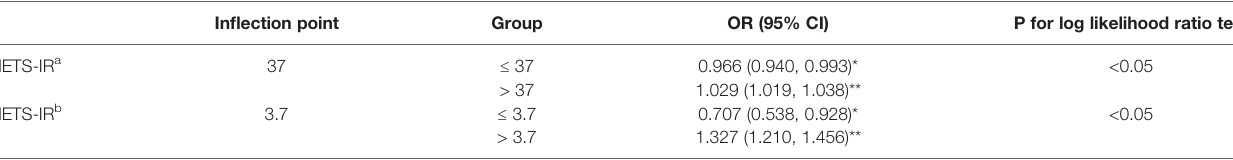
TABLE 3 | Threshold effect of METS-IR on SC-MI using piecewise binary logistic regression models.